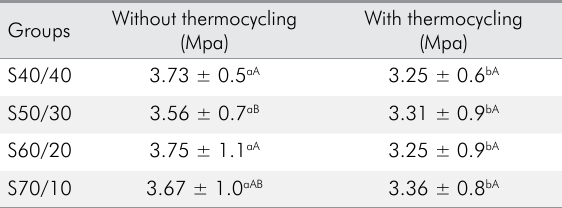
Table 3. Average micro-shear bond strength ( μ SBS) values in the experimental groups, according to the different conditions (with or without